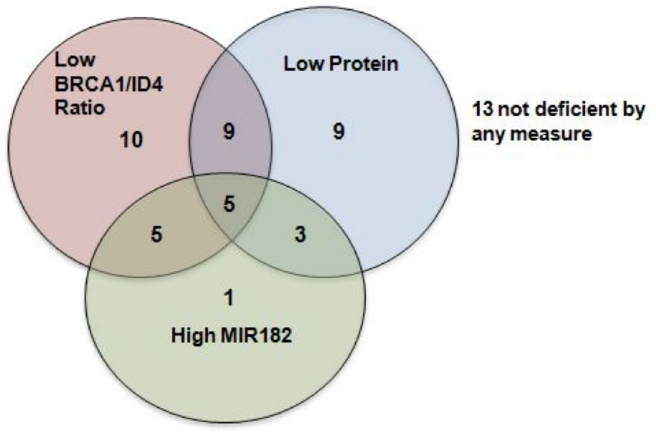
Fig 6. Shared BRCA1 deficiency measures in TNBCs n = 55. Shared BRCA1 deficiency measures in TNBCs n = 55.A Venn diagram, showing the overlap of TNBCspecimens deficient in BRCA1 by the three different measures.